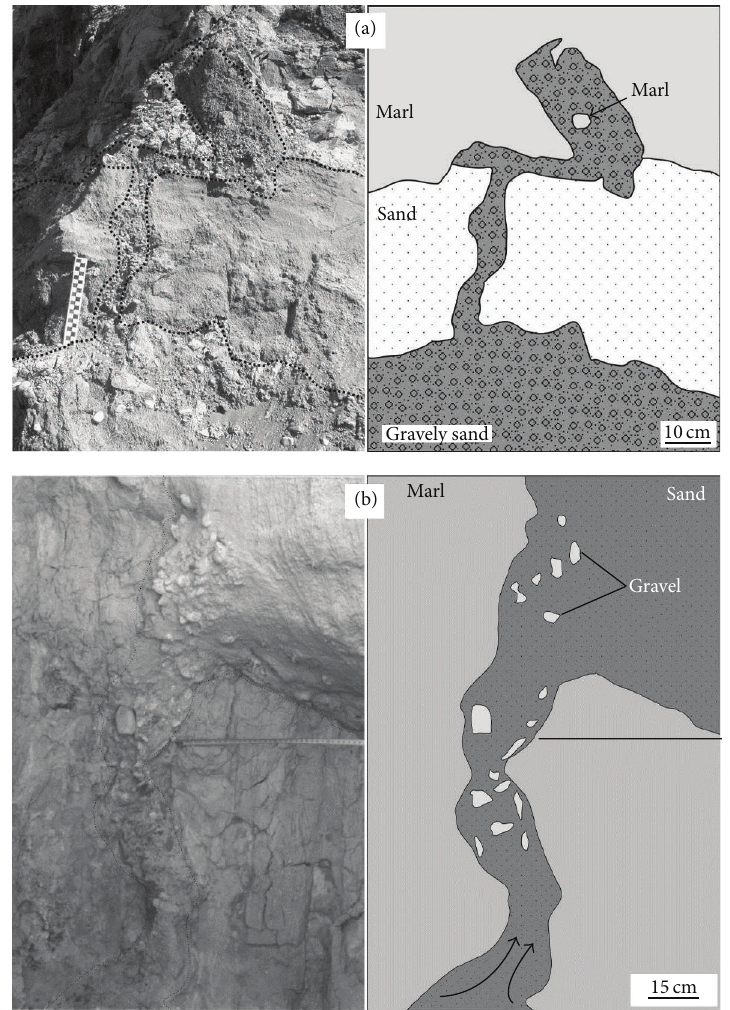
Figure 5: Clastic dikes in the study area. (a) Gravelly coarse-grained sand cuts through the sand layer and is intruded into overlying marls (37.769 N, 29.155 E). (b) Clastic material with fragments up to a max. 4cm of gravel size intruded through marls (27.792 N, 29.130